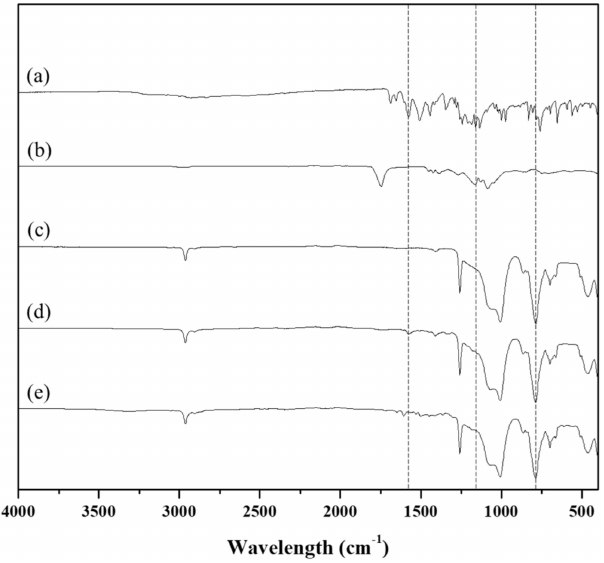
Figure 4. ATR-FTIR spectra of ( a ) intact tranilast, ( b ) intact PLGA, ( c ) I/I, and the surfaces of the PC/Tr/I ( d ) with and ( e ) without the coating dot. The dashed lines show the characteristic peaks.